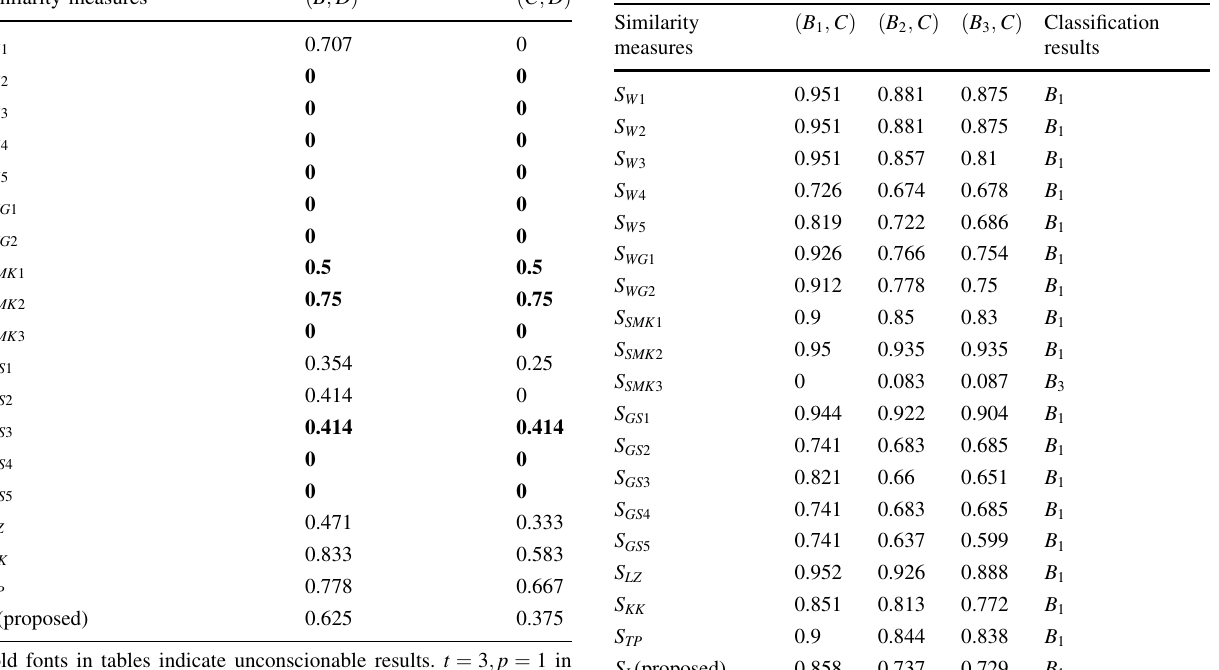
Table 3 The results of different similarity measures for pattern recognition